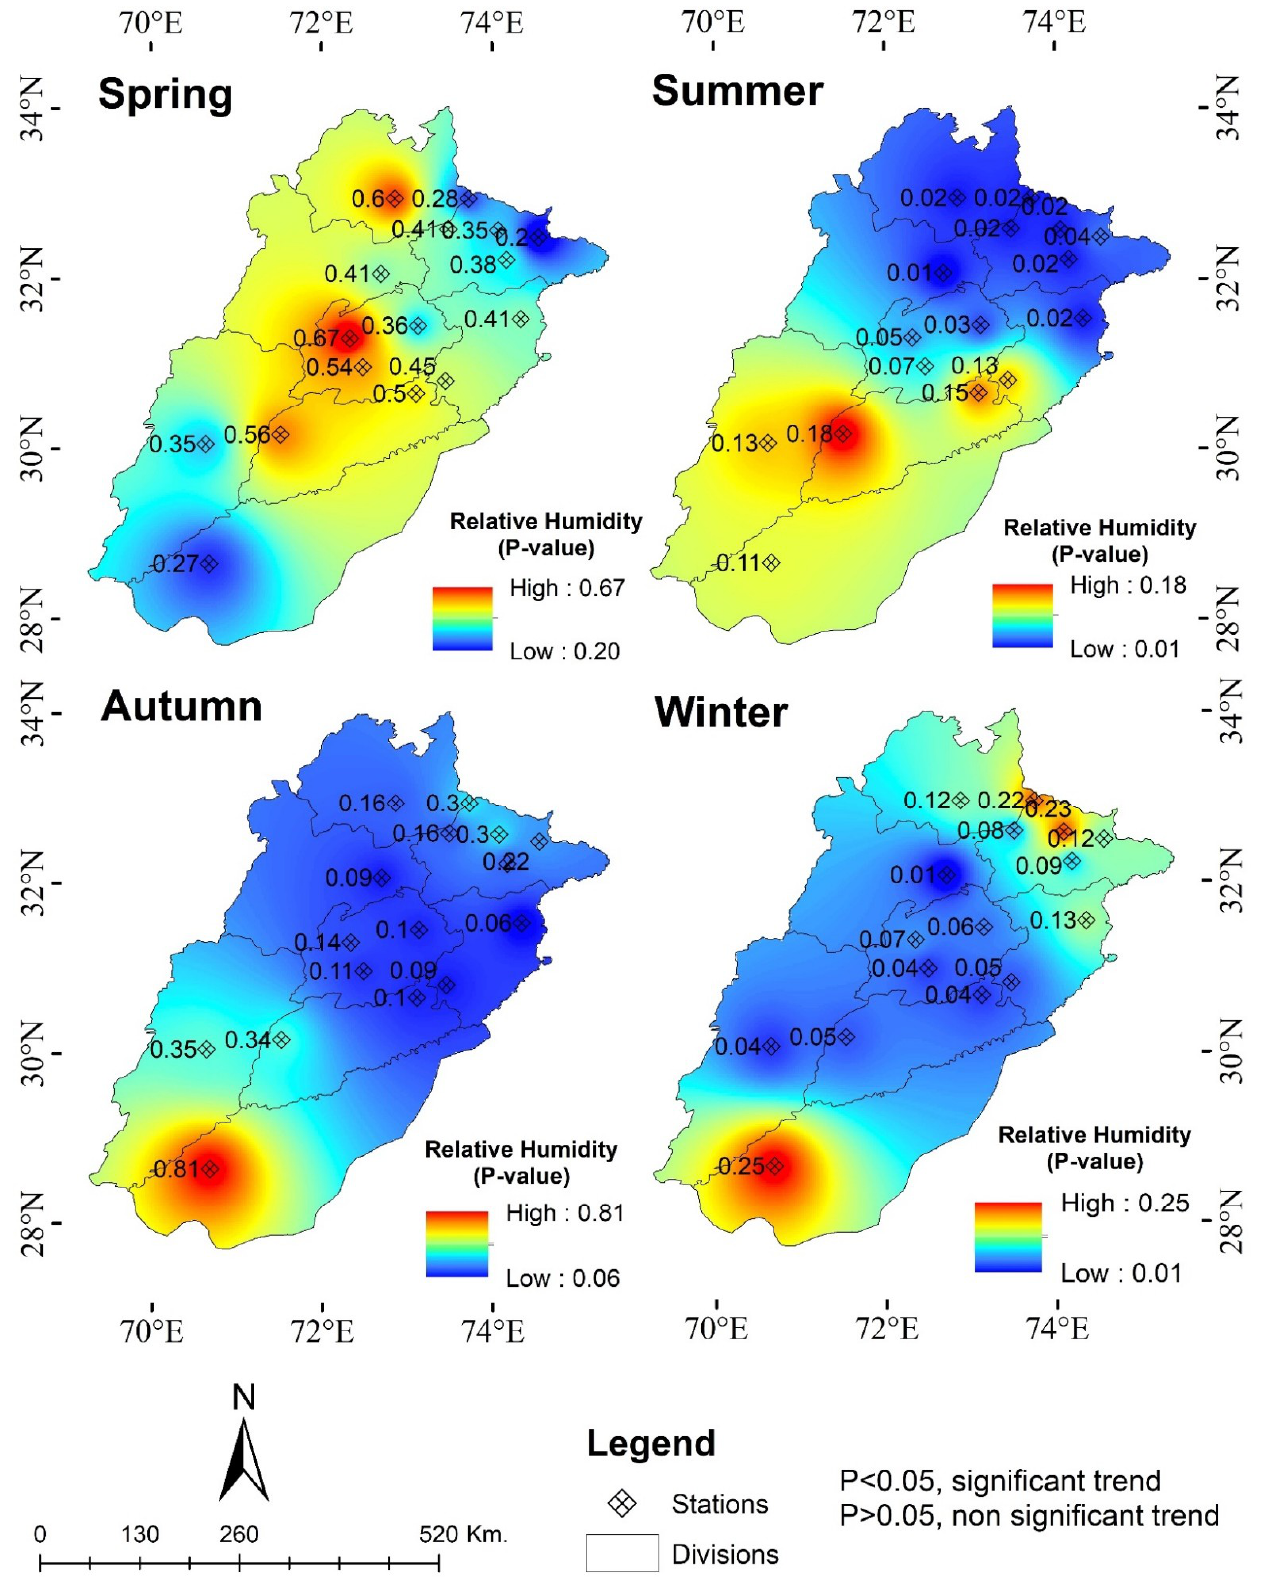
Figure 7. Seasonal p -values and the trends in relative humidity of the 16 stations of Punjab, Pakistan, over the period 1979– 2014.